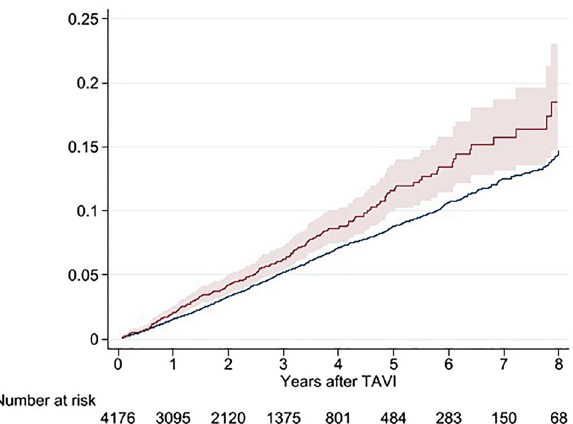
Figure 1. Accumulated risk for stroke up to 8 years after TAVR presented as a Kaplan–Meier failure function with 95% CI. Blue indicates accumulated standardized incidence calculated for this cohort of patients. Curve truncated at 8 years due to small numbers.